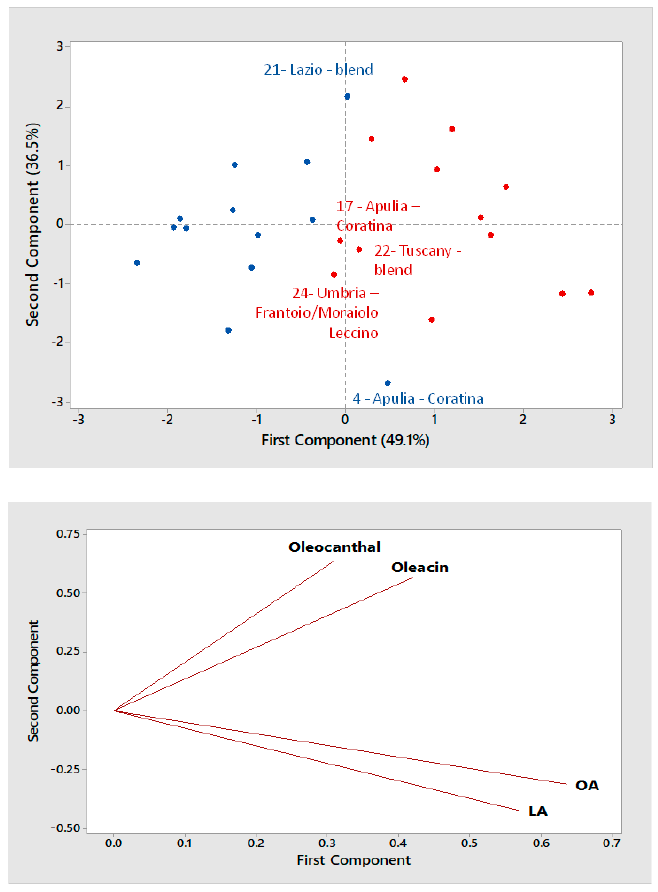
Figure 4. Score plot ( top panel ) and Loading plot ( bottom panel ) referred to the first two components provided by Principal Components Analysis (PCA) based on average normalized peak areas obtained for OA, LA, oleacin and oleocanthal (including the contribution of their carboxylic derivatives, if present) after the RPLC-ESI(-)-FTMS analysis of two replicated extracts for each of 26 Italian EVOOs produced during the 2016/2017 campaign. Olive oils produced using a three- or a two-phase horizontal decanter are indicated by blue and red dots, respectively. The sample numbering for emphasized samples is the same adopted in Table 1.